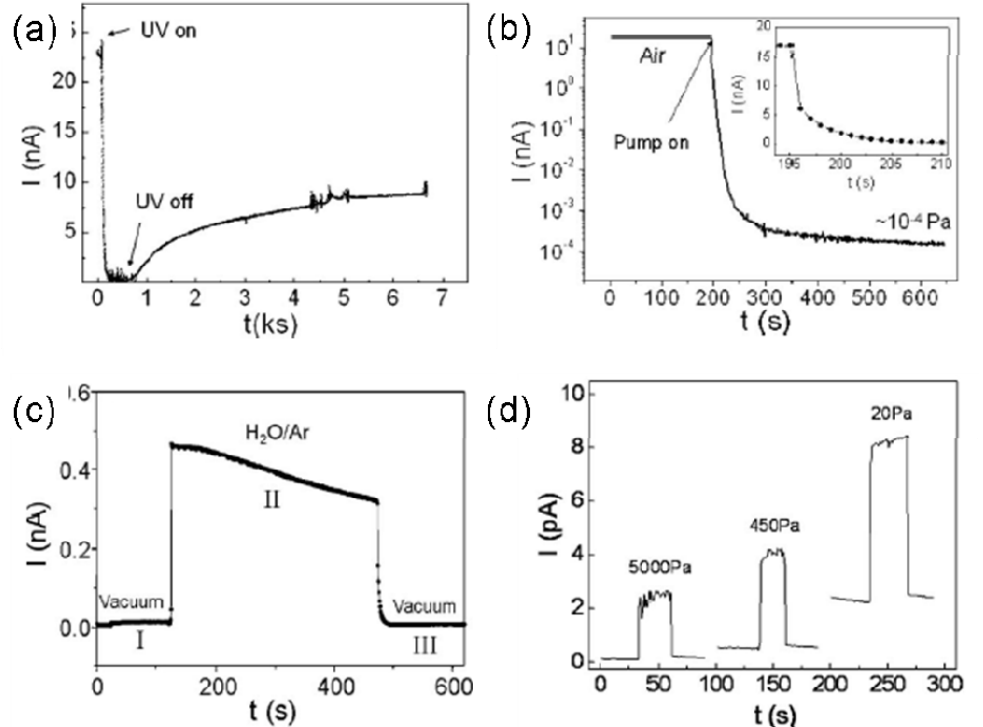
Figure 10. (a) UV response of CeO vacuum; (c) Photocurrent response in H different dry O . Reproduced from 2